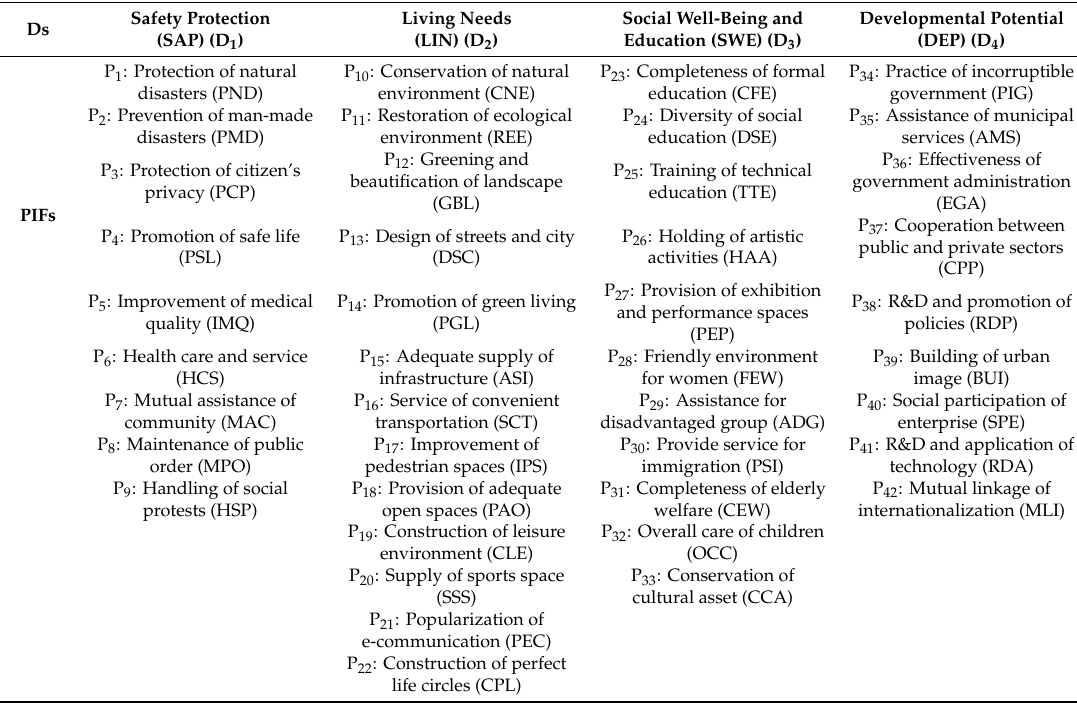
Table 2. Possible impact factors